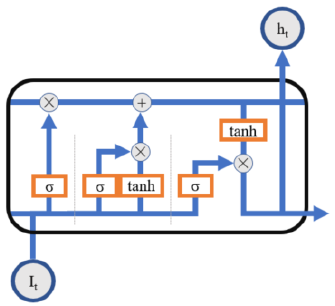
Figure 1. Structure graph of short and long time memory network unit.